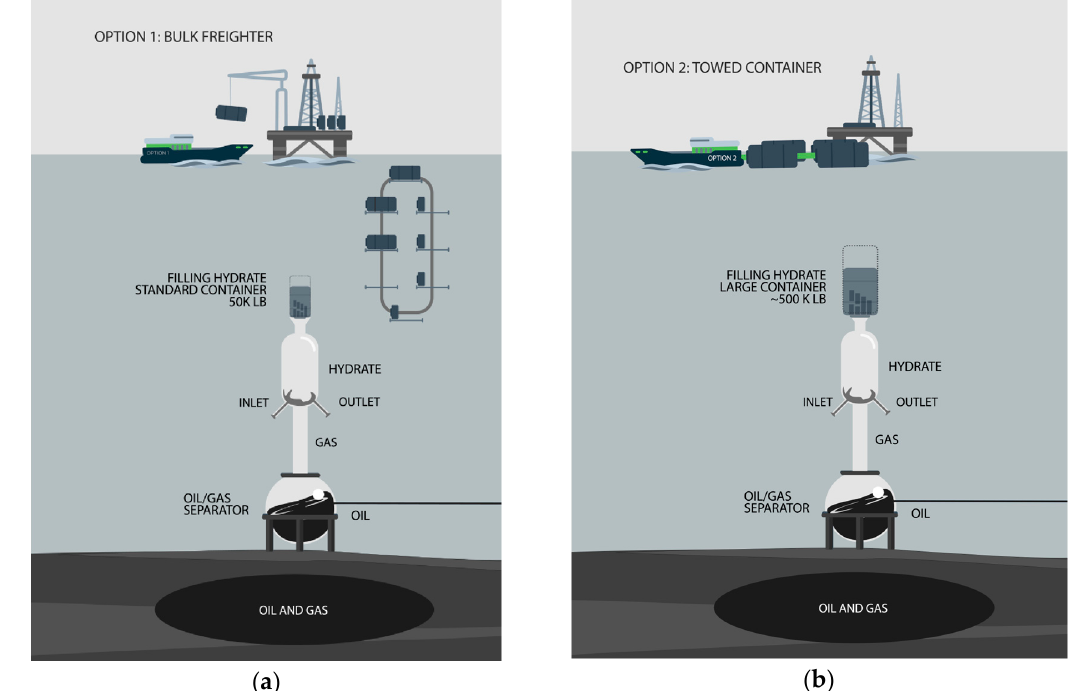
Figure 1. Notional concept of the proposed method for extracting natural gas from off-shore petroleum reserves. ( a ) Option 1, natural gas hydrate is transported in a bulk freighter. Standard-sized containers are filled near the ocean floor, raised (or floated up) to the surface, and emptied onto the bulk freighter which is then covered before transport to shore; ( b ) Option 2, natural gas hydrate is transported by towed containers. Large containers are filled near the ocean floor, raised (or floated up) to the surface, and transported to shore.